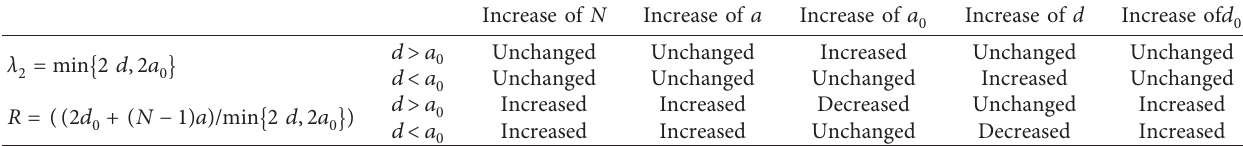
Table 5: The change of λ